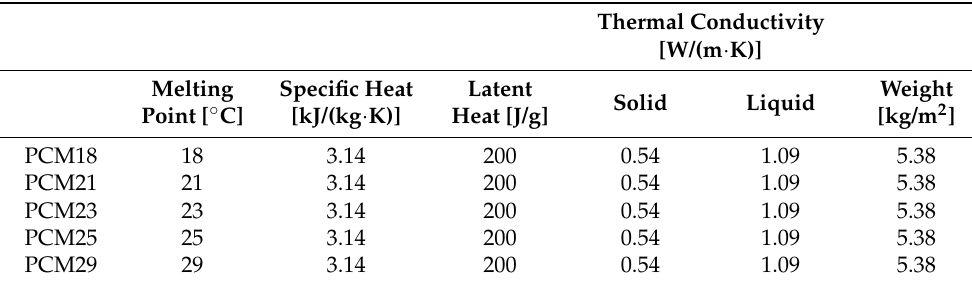
Table 5. Thermo-physical properties of different typologies of the same bio-PCM.